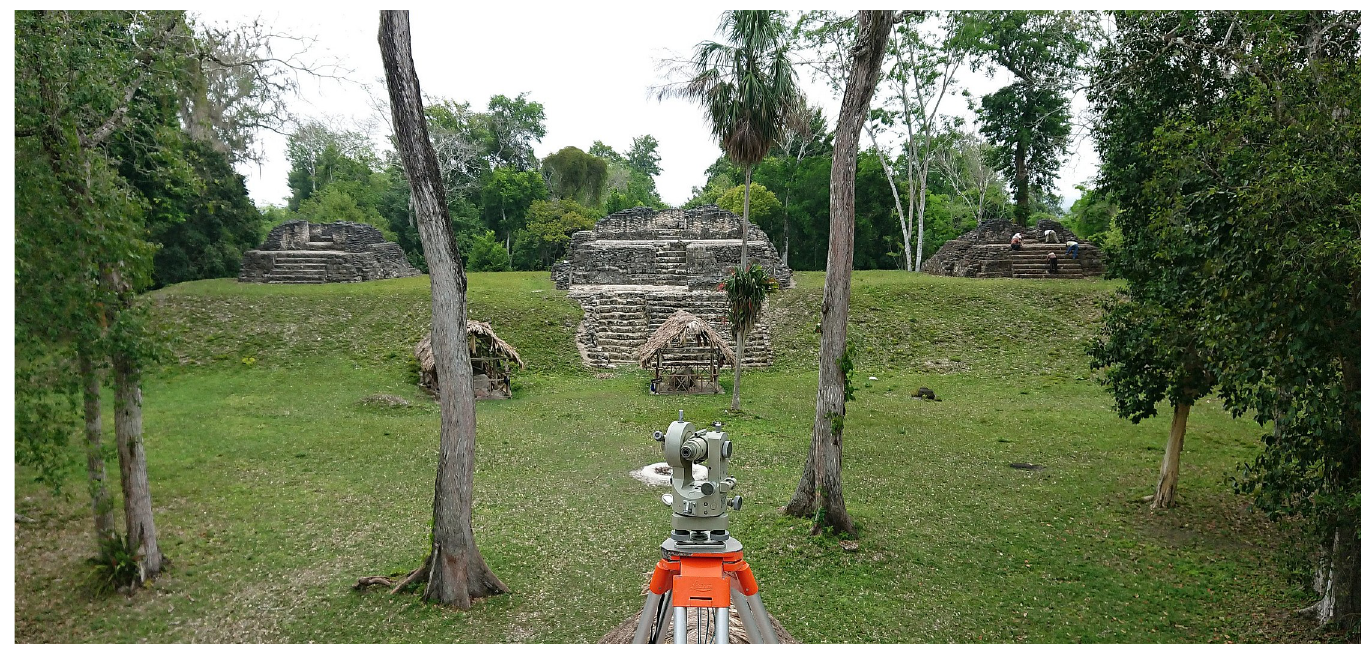
Fig 7. Group E of Uaxactu´n, east platform with Temples E-1, E-2 and E-3, viewing east from the western pyramid (Structure E-7-sub-2).